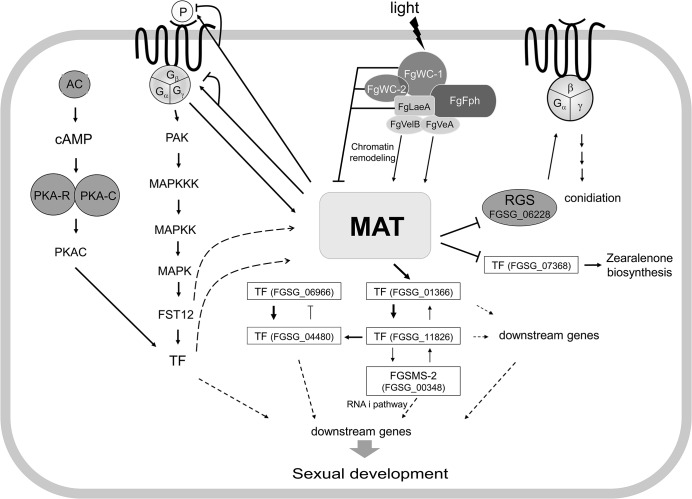
Schematic diagram of possible regulatory pathways of MAT-mediated sexual development in F. graminearum.The expression of both MAT loci are regulated by several environmental cues (e.g., light), probably via chromatin remodeling by the FgVeA complex and/or G-protein signaling pathways, and control the expression of putative target genes via regulatory cascades and/or networks involving several downstream transcription factors (TFs) and an RNAi regulator (FgSMS-2). Abbreviations: MAT, mating-type proteins encoded by both MAT1-1 and MAT1-2 loci; AC, adenyl cyclase; PKA-R, protein kinase A regulatory subunit; PKA-C, protein kinase A catalytic subunit; PAK, protein kinase; FST12, an F. graminearum ortholgoue of the yeast STE12; RGS, Regulator of G-protein signaling; P, pheromones. Solid lines with triangular and flattened arrowheads represent gene activation and repression, respectively. The dashed arrows indicate possible regulatory directions, not determined by qPCR.